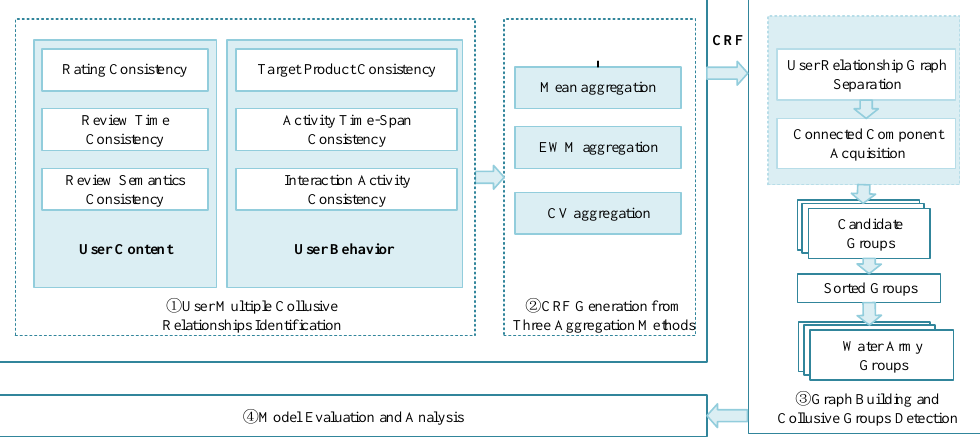
Figure 1. Overall Figure 1. Overall Design